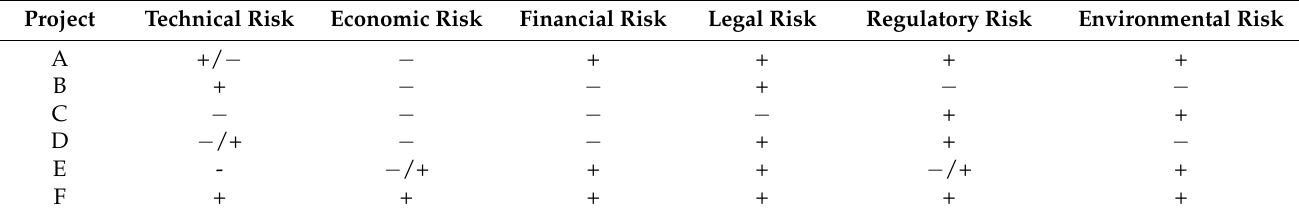
Table 11. Risks of CHP investment projects during the control